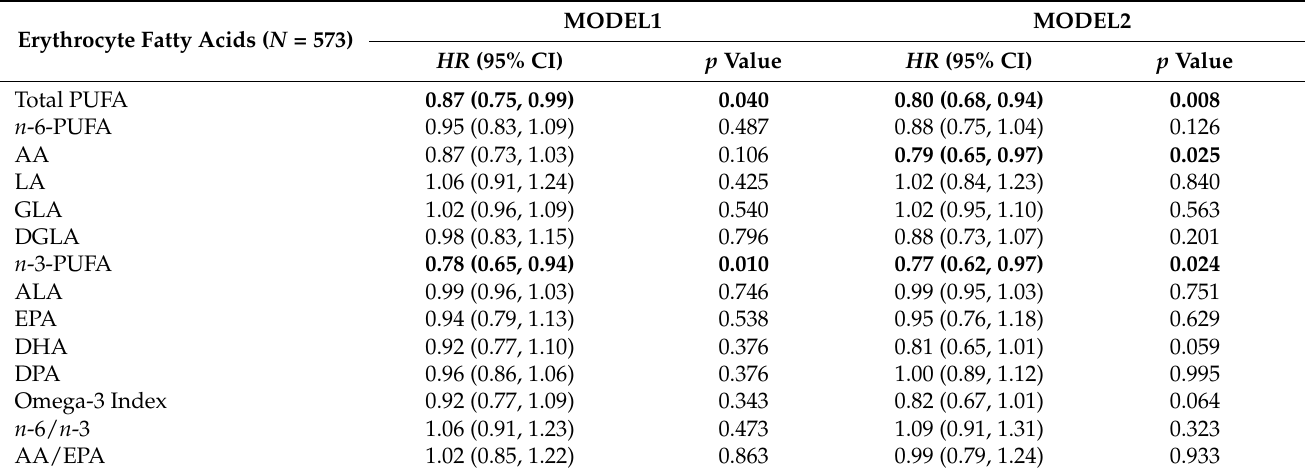
Table 3. The associations between maternal erythrocyte fatty acids and offspring allergic disease a within 2 years of